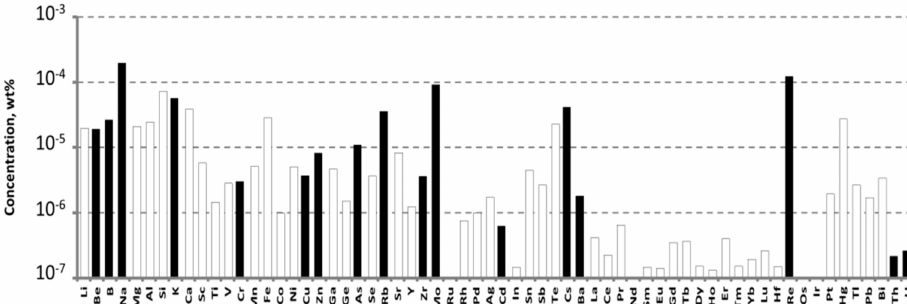
Figure 1. Impurities concentrations determined by ICP-MS in the purified WO 3 . Hereafter, the empty bars indicate the limits of determination (LD) of ICP-MS analysis.